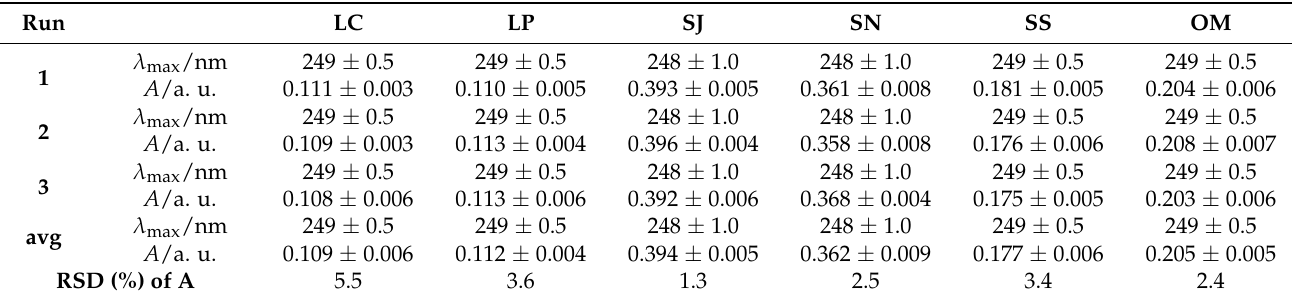
Table 1. Reproducibility of the pretreatment method. The maximum absorption absorbance (A) at a characteristic wave- length ( λ max ) is listed as mode of average ± standard deviation (SD). Relative standard deviations (RSD) are calculated and listed. Six UV-Vis spectra were obtained from each fish species. The extraction was conducted following the protocol detailed in experimental Section 3.2. Briefly, the initial extract of fish muscle sample was obtained by pretreating 2 g of fish muscle tissue sample with 10 mL of trifluoroacetic acid (TFA) aqueous solution (0.1%, v / v ), and diluted 80-fold with deionized (DI) water for further analysis. Fish samples of Larimichthys crocea (LC), Larimichthys polyactis (LP), Scomber japonicas (SJ), Scomberomorus niphonius (SN), Salmo salar (SS) and Oncorhynchus mykiss (OM) were analyzed.